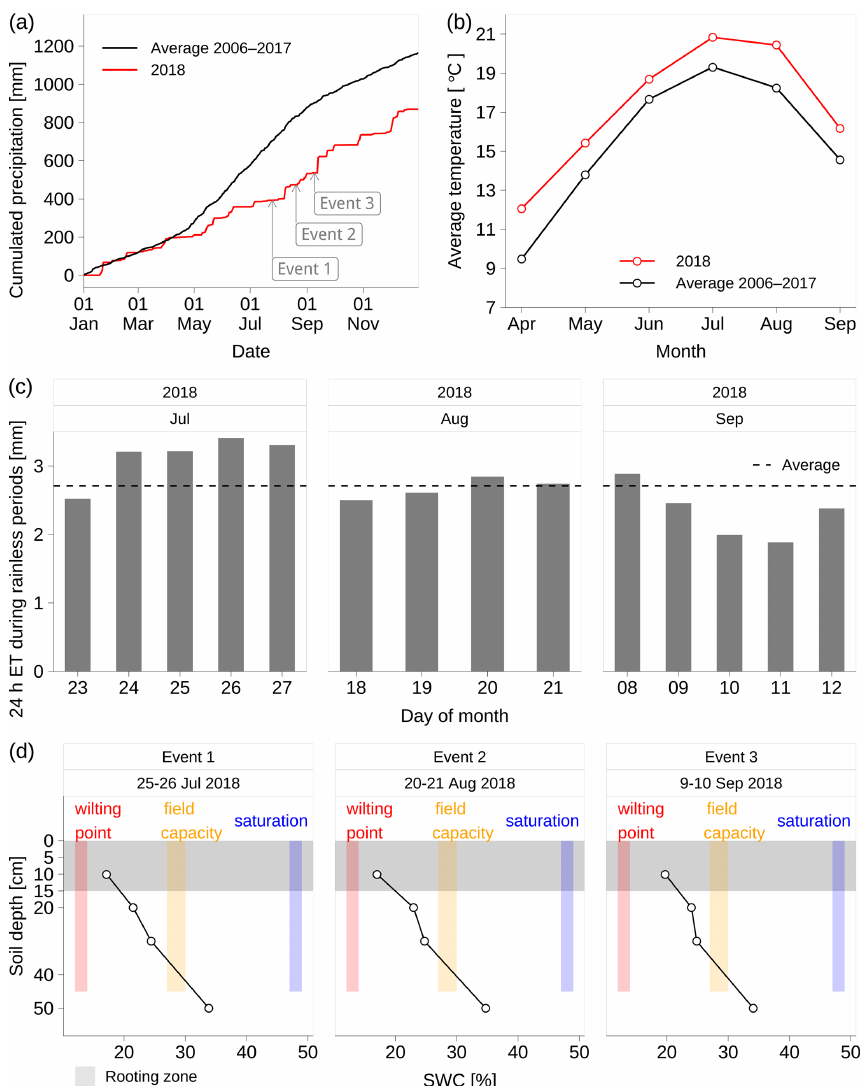
Figure 1. Dry and hot summer in 2018. (a) Year-to-date precipitation in 2018 as compared to the average levels over 2006–2017 and the corresponding values before the three events. (b) Average temperature ( T a2m ) from April to September in 2018 as compared to the corre- sponding average levels over 2006–2017. (c) The 24h evapotranspiration (ET) during the corresponding rainless periods of the three events. (d) Volumetric soil water content (SWC) at the Chamau site; the wilting point is 12%–14% calculated from Eq. (C1) given soil water poten- tial =− 1500kPa and soil texture in Table C1; the field capacity is 27%–30% calculated from Eq. (C1) given soil water potential =− 33kPa and soil texture in Table C1; and saturated water content is 47%–49% calculated from Eq. (C4) given soil texture in Table C1; the rooting zone is in the top 0–15cm